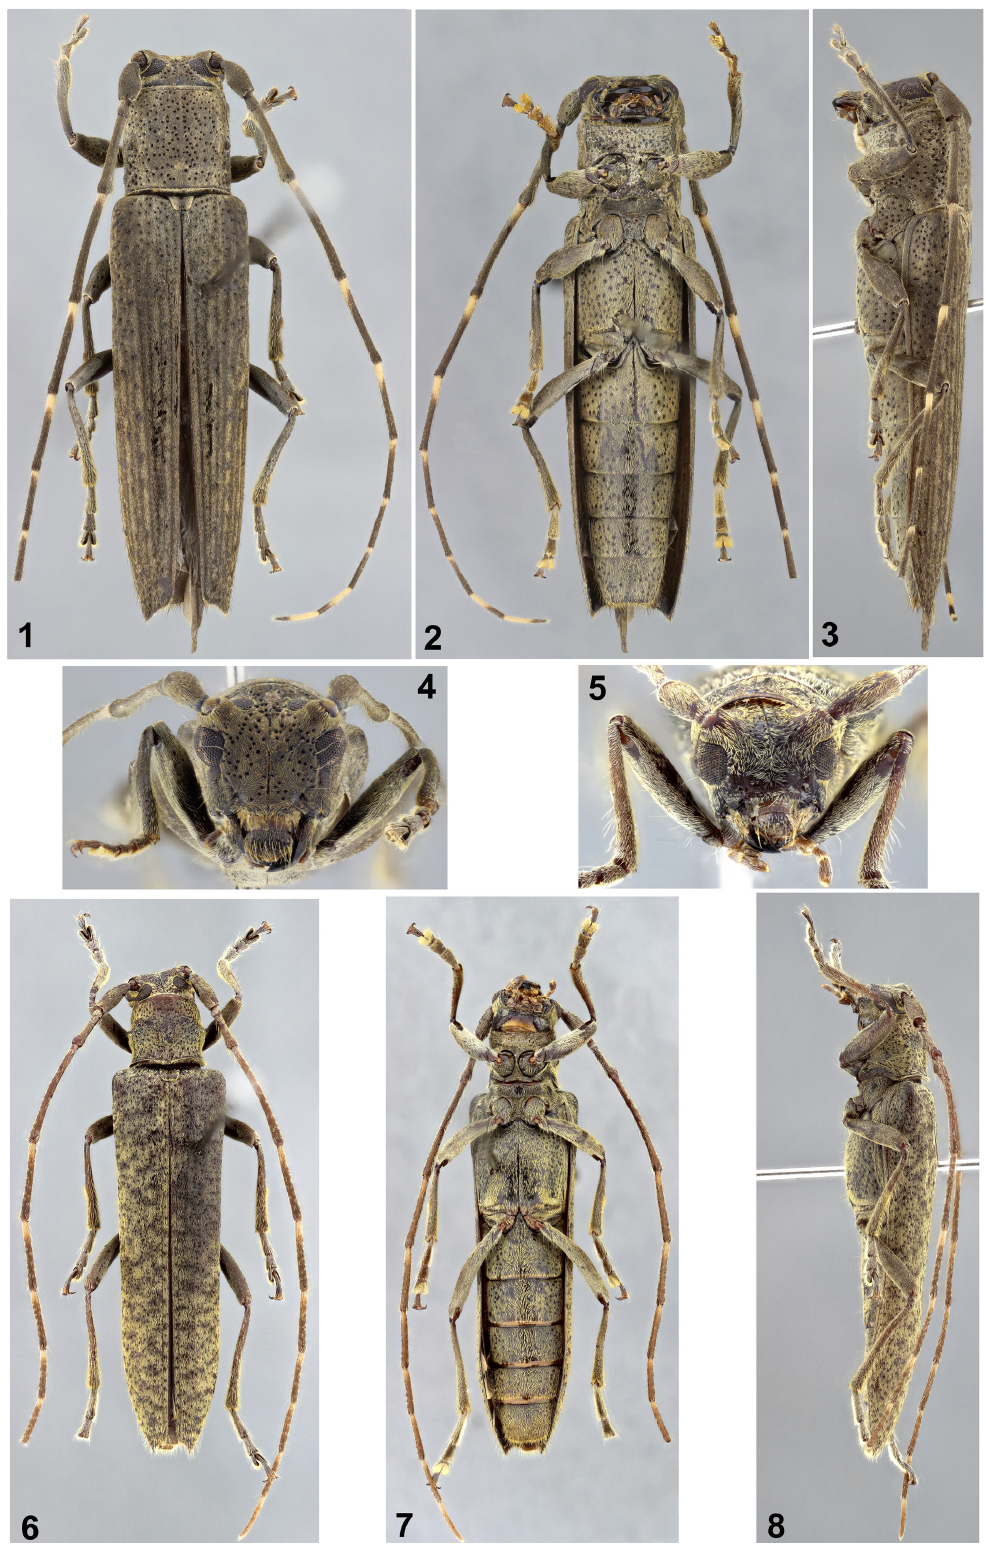
Figs 1–8. – 1–4. Nyctonympha sinjaevi sp. nov., holotype, ♀. 1 . Dorsal habitus. 2 . Ventral